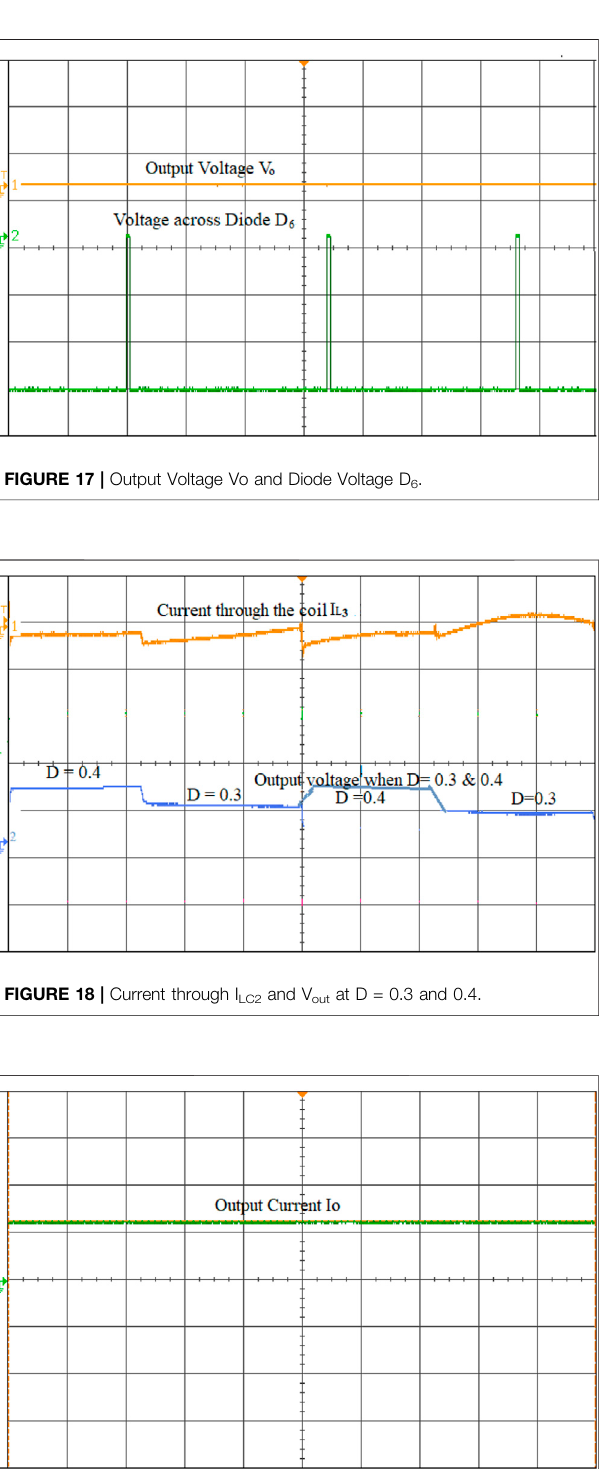
calculate downtime costs, N years and mean time between failures (MTBF) are taken into account. MTBF is the average time between system failures.